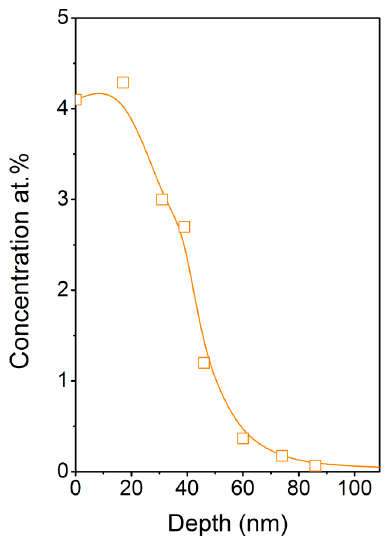
Figure 8. Concentration profile of Ag in AgNP-immobilized PET (14 mJ cm − 2 ) measured by Rutherford backscattering spectrometry (RBS).